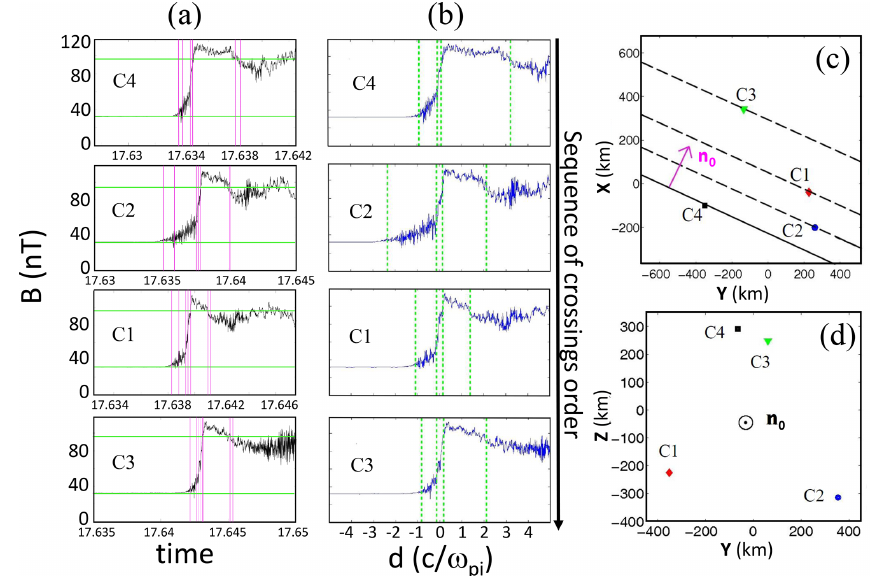
Figure 6. Time and spatial profiles along the normal of the magnetic field magnitude for the shock crossing on 31 March 2001 at 17:38UT are shown in (a) and (b) , respectively. For this shock crossing, v sh = 18km/s, M A = 4 . 1, θ B the four Cluster satellites for the event displayed at the reference time t ref defined for satellite C4 (see text) are reported within the plane defined by X GSE and the normal n 0 (c) , and within the plane perpendicular to n 0 (d) . (Panels (b) , (c) , and (d) are issued from Figs. 3 and 4 of Mazelle et al. (2010a).)